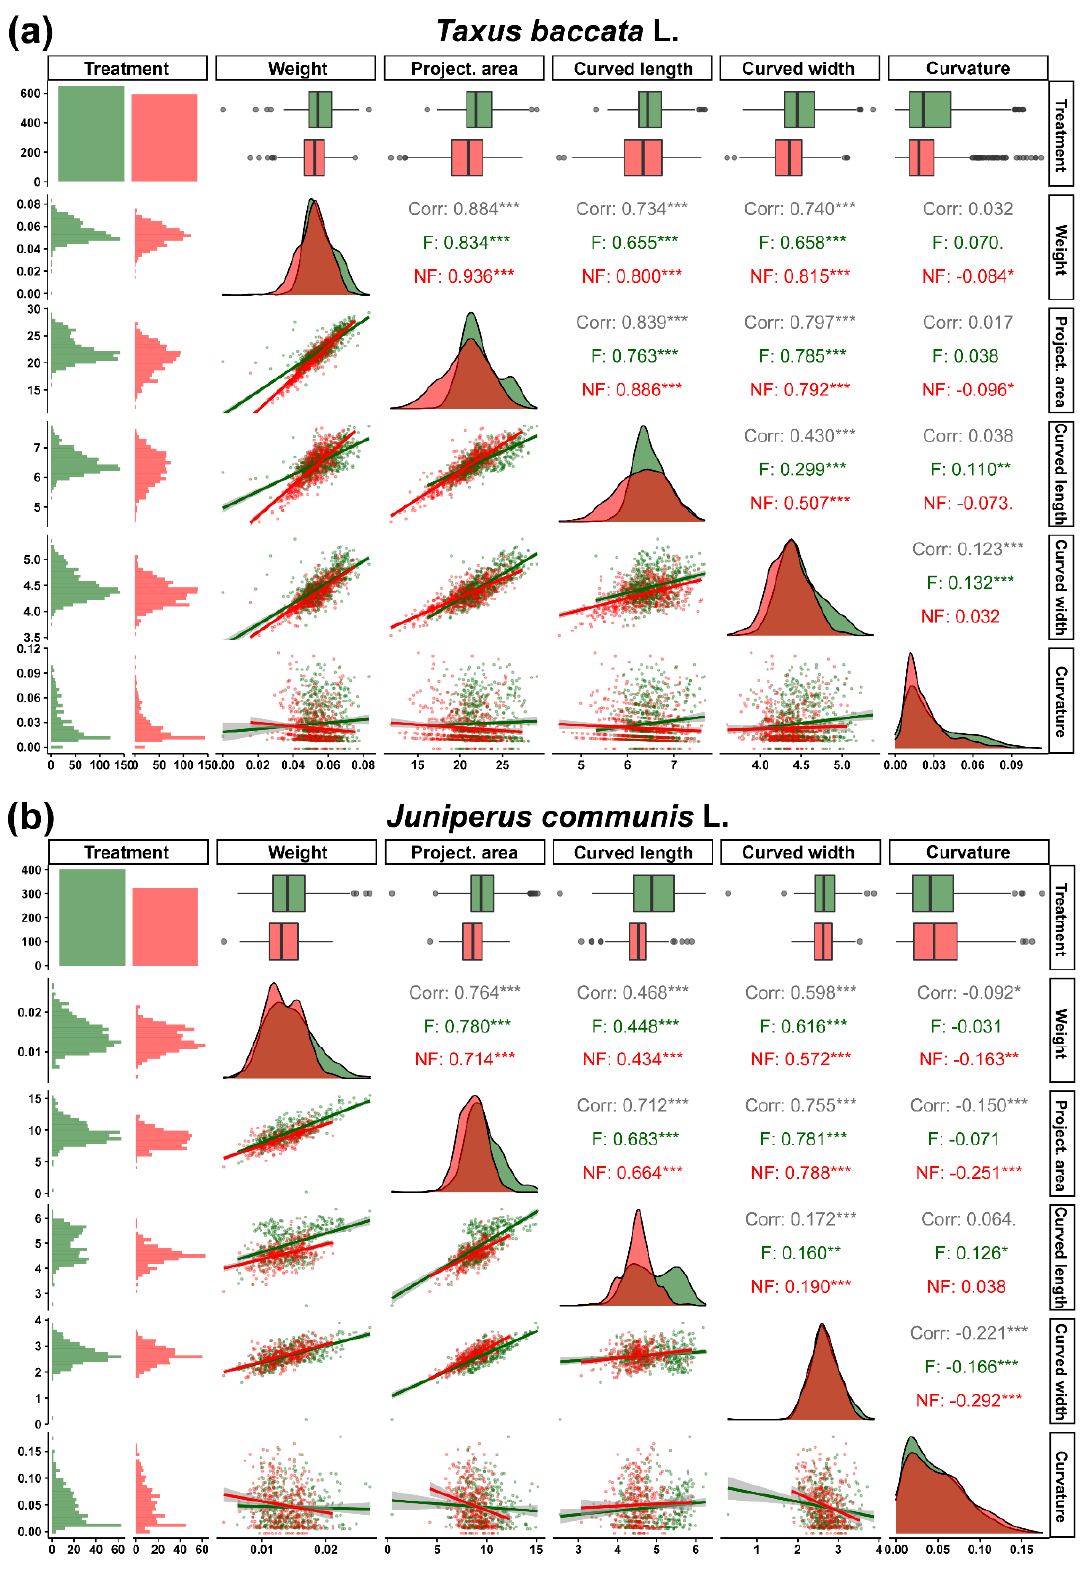
Figure 4. Correlation matrix and data distribution of seed weight (mg) and morphometric parameters (projected area, mm 2 ; curved length and width, mm) of ( a ) Taxus baccata L. and ( b ) Juniperus communis L. seeds, collected from plants grown in fertilised (green) and non ‐ fertilised (red) conditions. Stars indicate significant correlations (* p < 0.05, ** p < 0.01, *** p < 0.001).